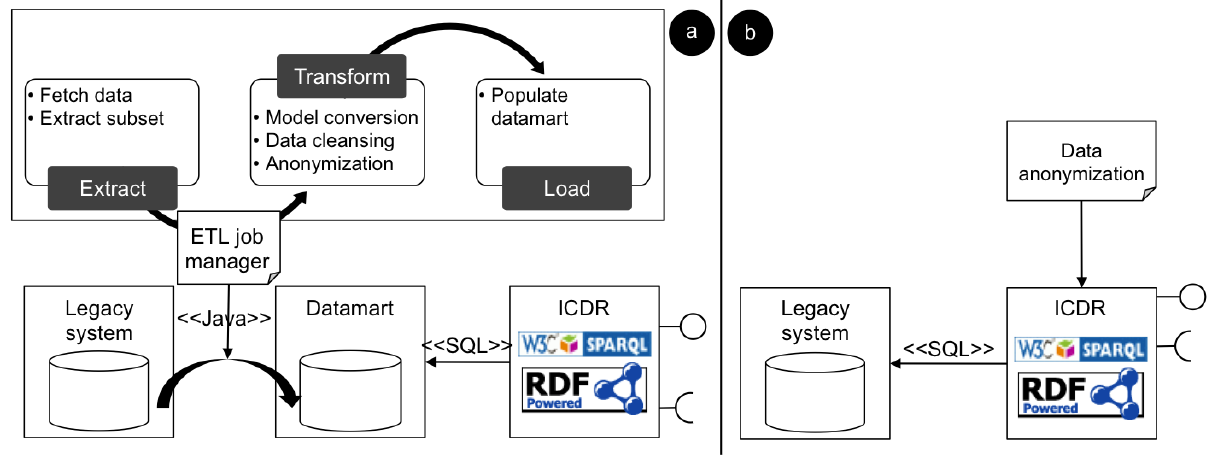
Figure 4. Local clinical data repository (lCDR) deployment and population model. (a) Production data are extracted daily to a local mirror